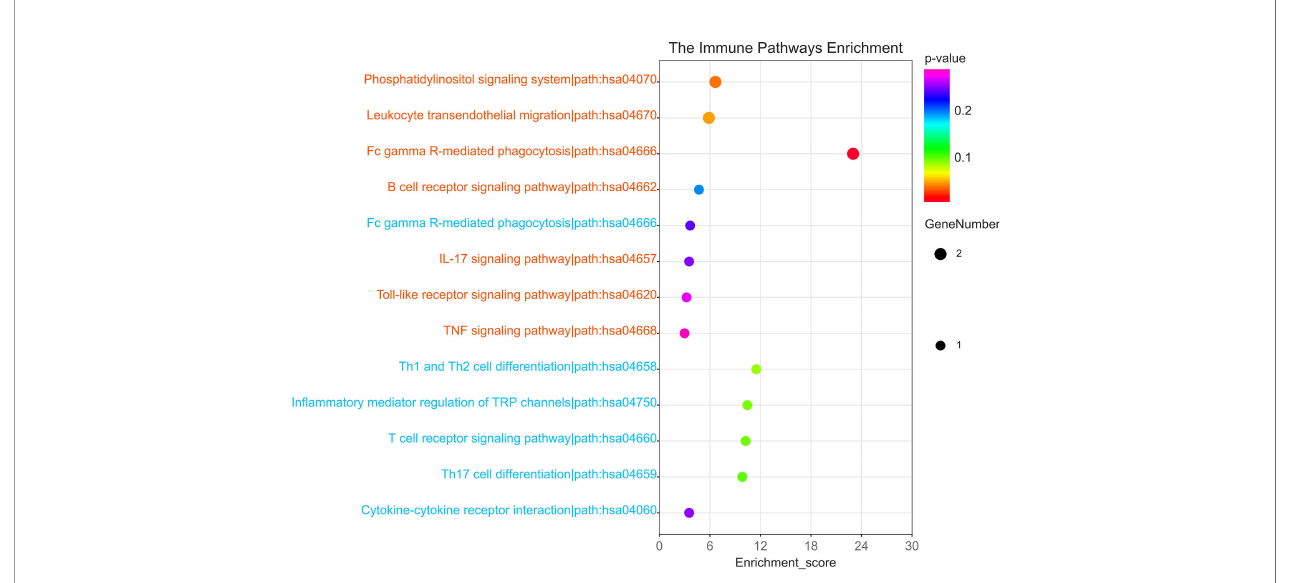
FIGURE 5 | The immune-related KEGG pathway of 64SDEGs. Red colour represented the pathway in which up-regulated SDEGs were involved while blue colour represents the pathway in which down-regulated SDEGs were